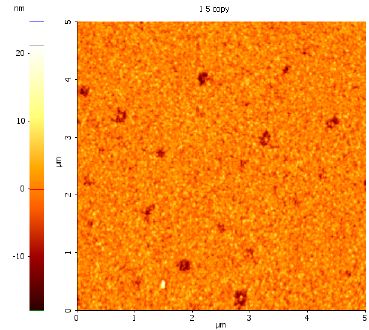
Figure 12. Surface topography of Si after 36 sccm SF 6 plasma treatment.